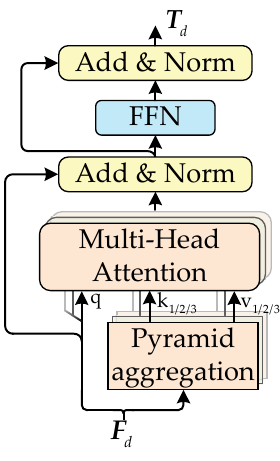
Figure 4. The pyramid transformer